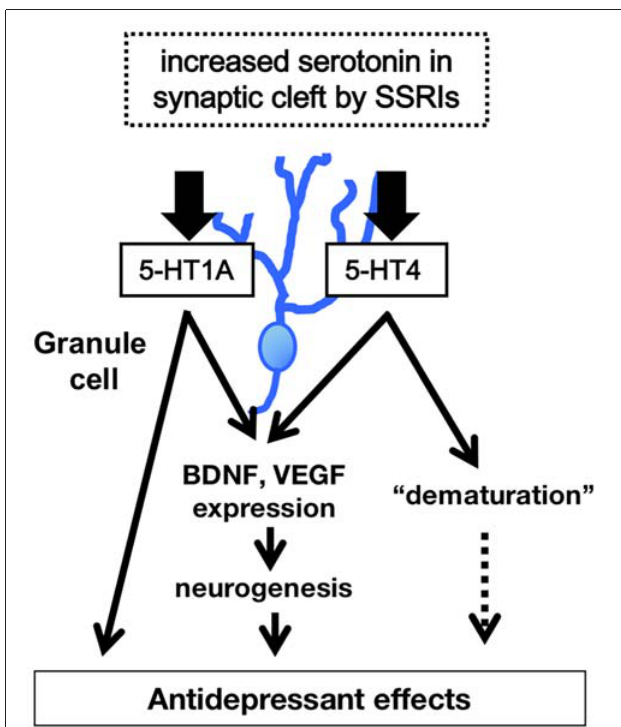
FIGURE 2 | Model of 5-HT1A and 5-HT4 receptor-mediated modulation of hippocampal function. The higher level of 5-HT in synaptic cleft in the DG induces increase in expression of neurotrophic factors such as brain derived neurotrophic factor (BDNF), facilitation of hippocampal neurogenesis, and dematuration of GCs via the 5-HT1A and 5-HT4 receptors in the DG. The signals of 5-HT1A and 5-HT4 receptors in the DG contribute to several antidepressant and anxiolytic